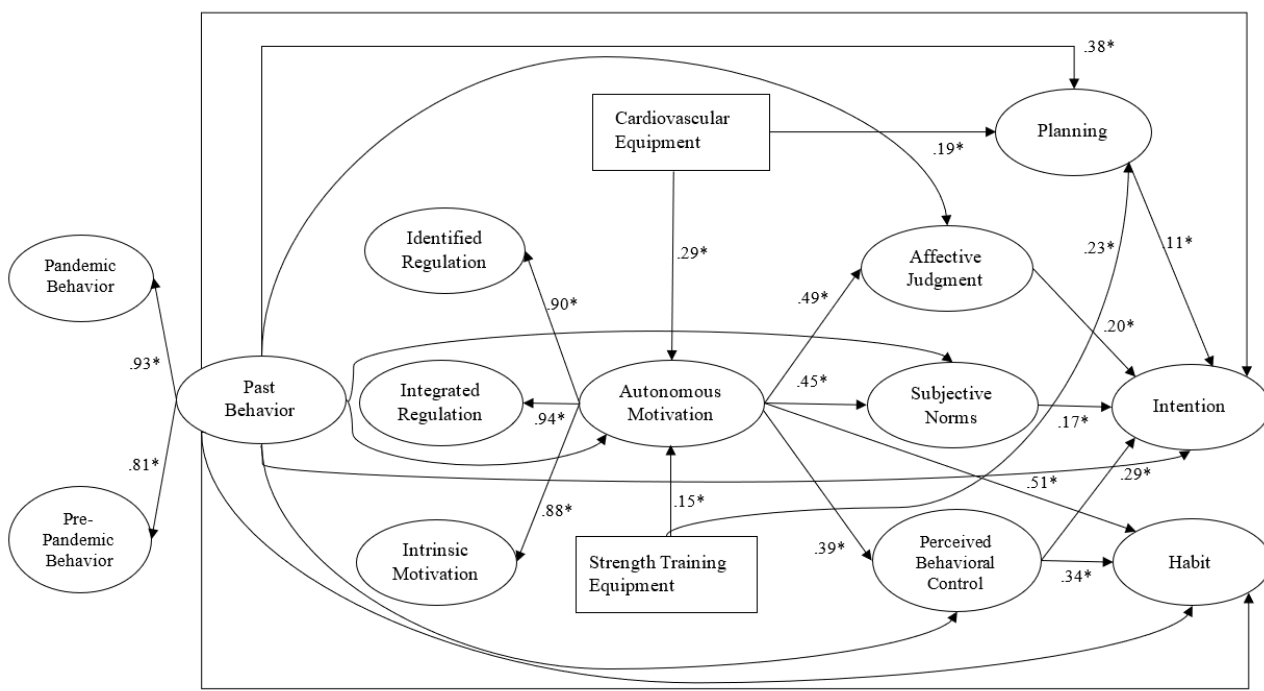
Figure 1. Note. Effect sizes are standardized parameter estimates from a structural equation model.* p < 0.001. Estimates for non-hypothesized pathways, including direct past behavior estimates, and demographic variables that controlled for model effects have been omitted for clarity.